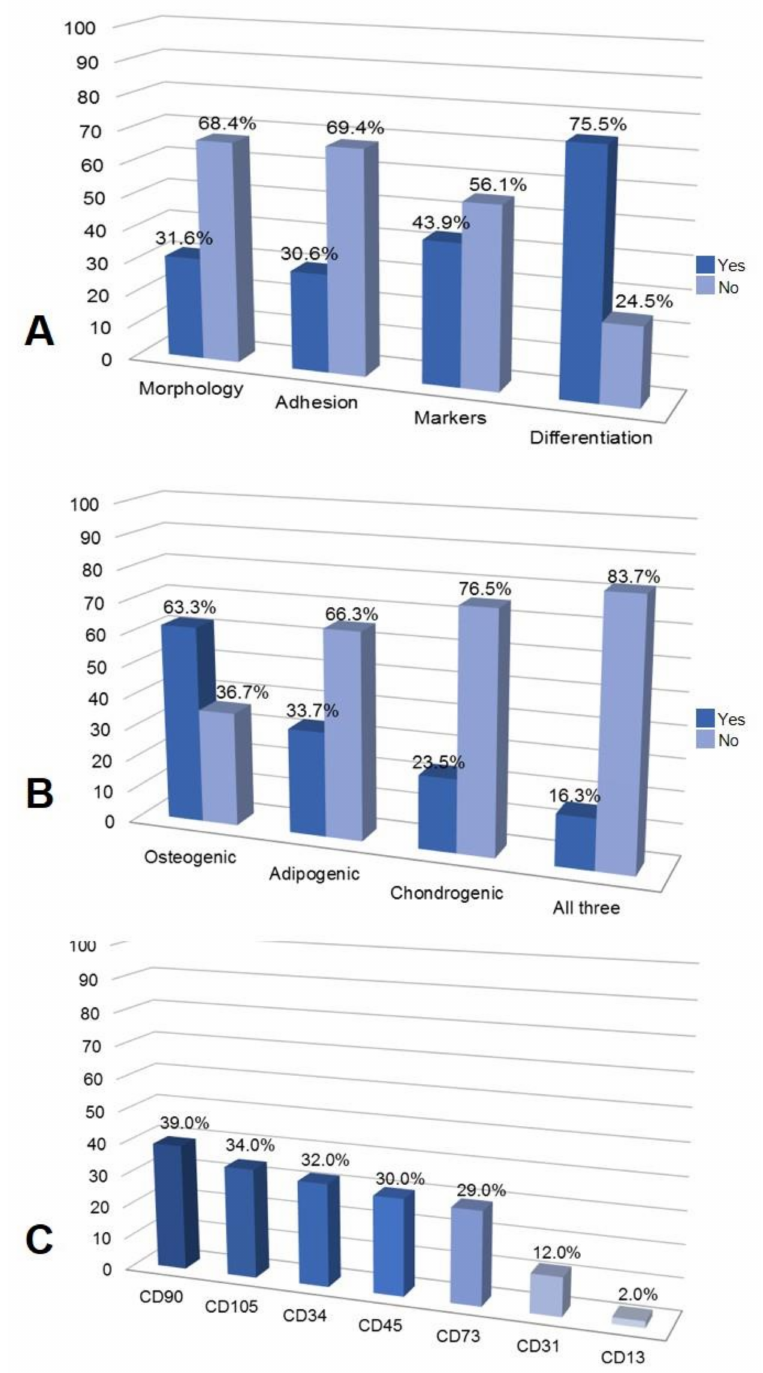
Figure 9. AD-MSCs characterization. ( A ) % of selected articles that used the International Society of Cellular Therapy criteria for characterization—morphology, adhesion, markers and differentiation. ( B ) Osteogenic, adipogenic, chondrogenic differentiations or all differentiations analyzed in the selected articles. ( C ) Markers analyzed in the selected